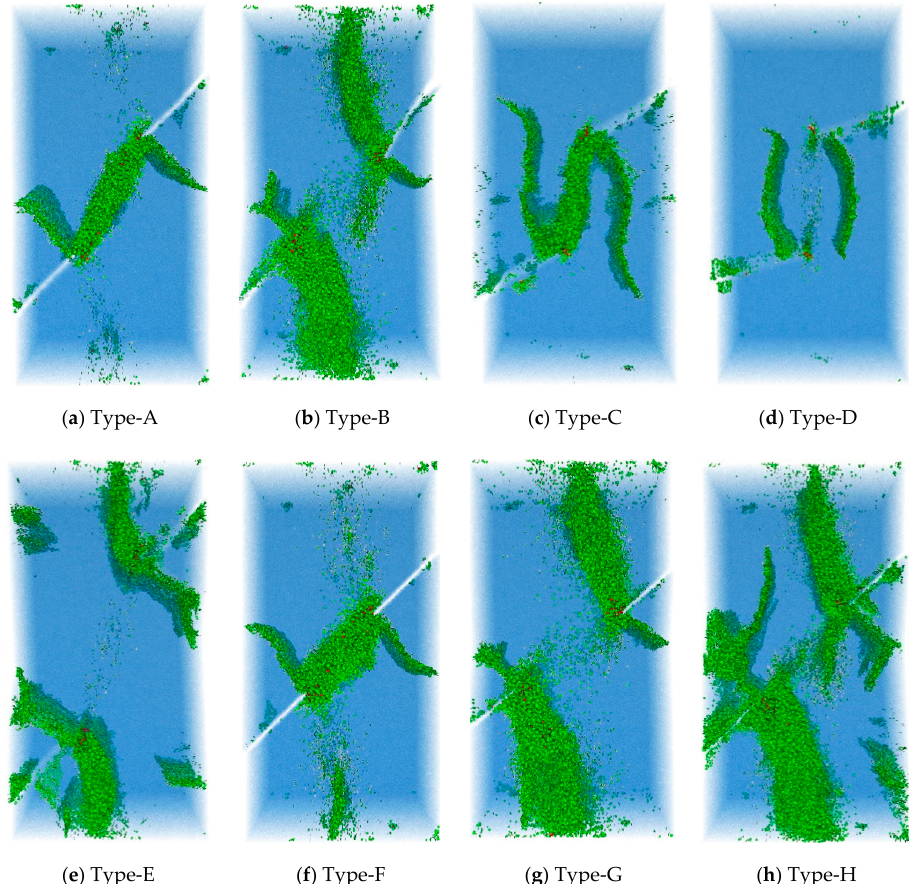
Figure 7. 3-D final failure patterns of the pre-fissured marble specimens in the uniaxial compressive